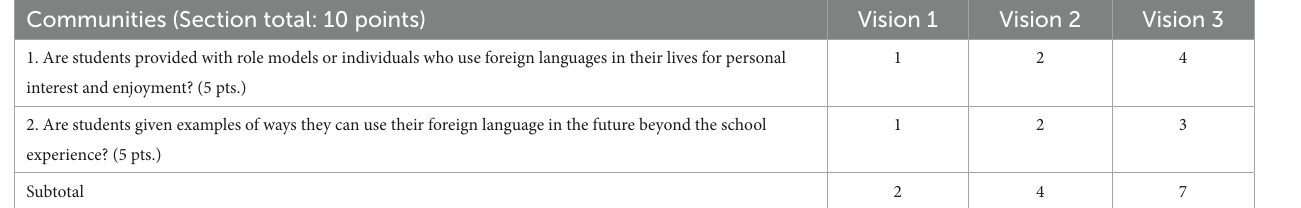
TABLE 4 Evaluation of Vision Series textbooks based on communities. Communities (Section total: 10